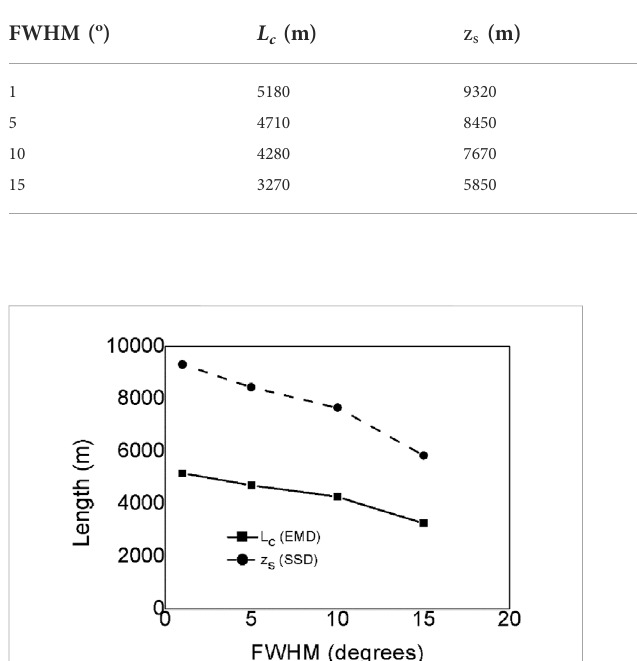
TABLE 1The calculated length L c for obtaining the EMD,lengthz s for establishinganSSD, and maximum length z SDM for realization ofthree-channel and two-channel ADM in each of the seven cores of a MM MC SOF for various widths of the Gaussian launch beam distribution. FWHM ( o )